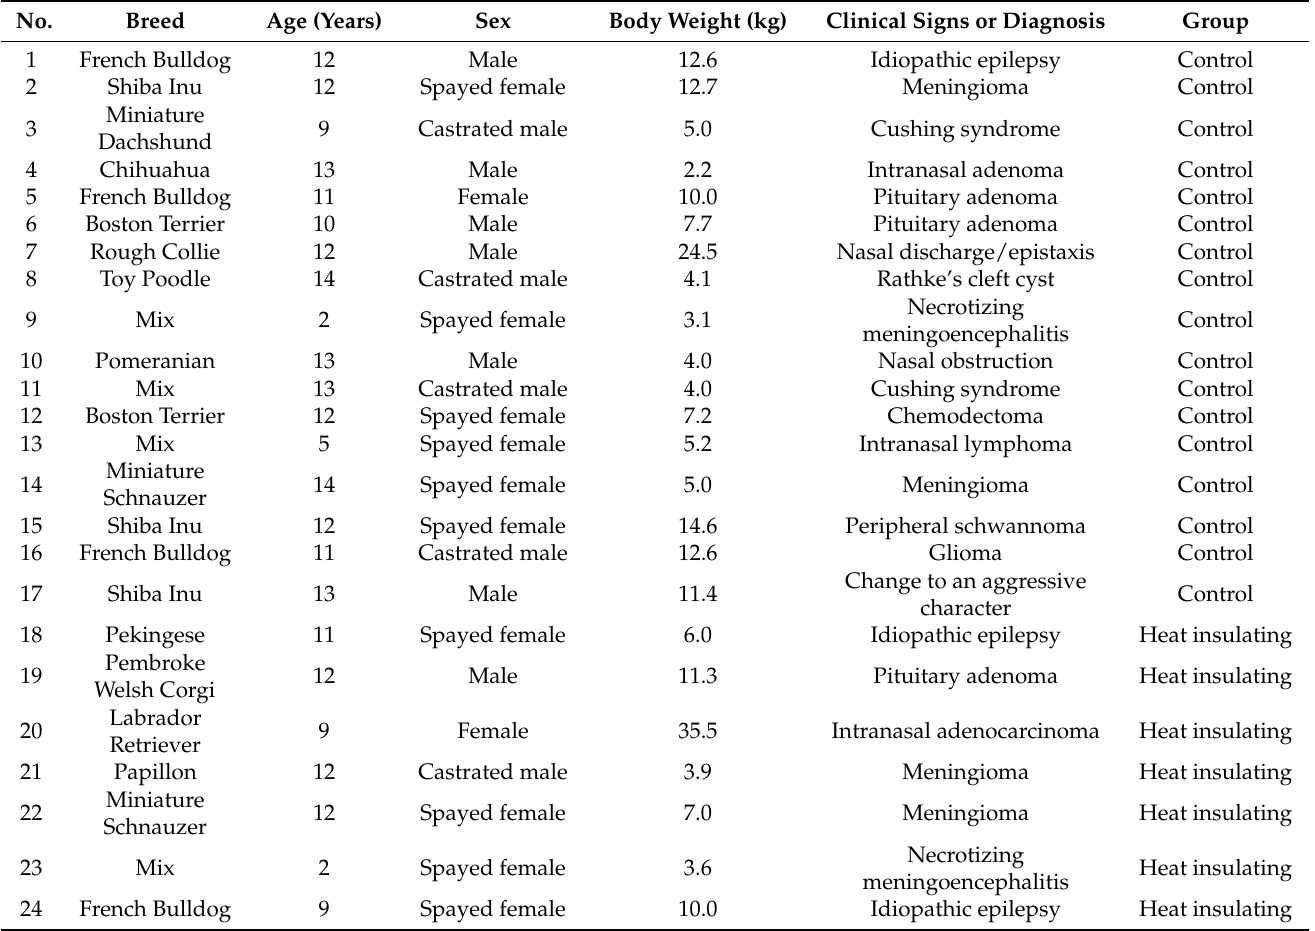
Table 1. Profiles of 24 dogs used in examination in this study.